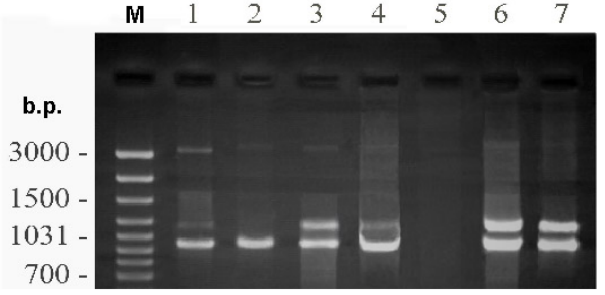
FIGURE 4 . Detection of A. laidlawii PG8 by PCR with primers LA16LF and LA23LR in plants ( V. minor L.). The lanes 1–4 contain PCR products of DNA extracted from plants infected with cells of adapted (1, 2) and unadapted (3, 4) culture of the mycoplasma through 4 days (1, 3) and 21 days (2, 4) after injecting. The lanes 5–7 correspond to negative (5) and positive (6, 7) controls – PCR products of DNA (230 ng) extracted from uninfected plants (5), mixed DNAs (230 ng/10 ng) of uninfected plants and cells of unadapted culture of the mycoplasma (6) and DNA (10 ng) extracted from cells of unadapted culture of the mycoplasma (7). The lane M corresponds to marker for length of DNA fragments